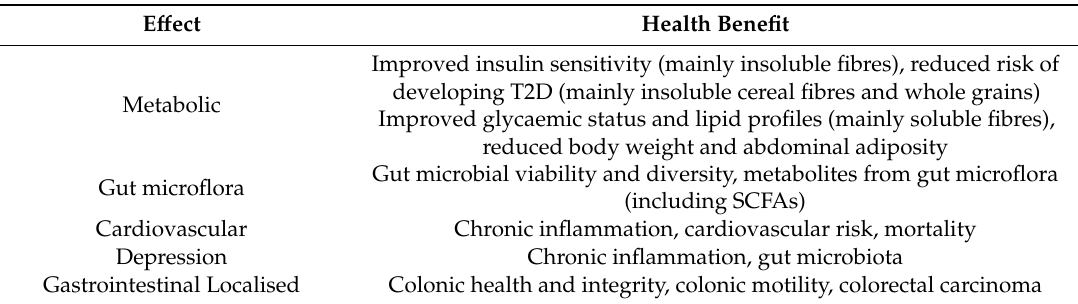
Table 1. Summary of the health benefits of dietary